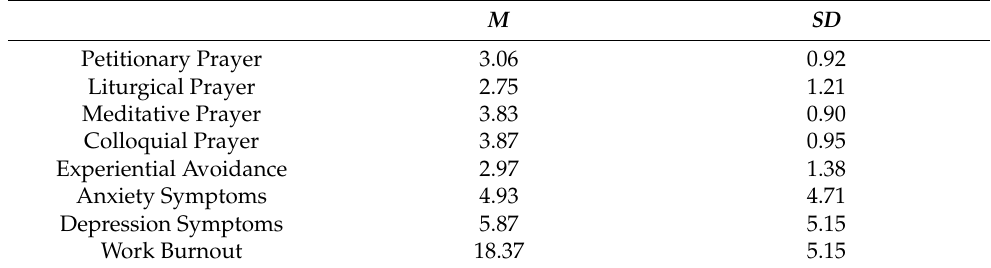
Table 1. Means and standard deviations of variables tested in regression models.